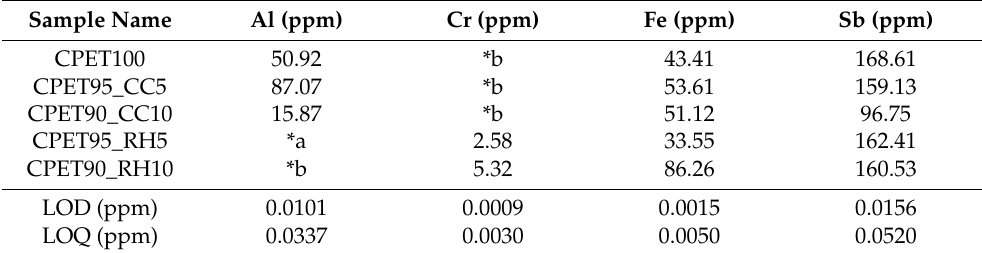
Table 3. Inorganic element composition of selected compounds (Al, Cr, Fe, Sb) in CPET and blends containing coffee chaff or rice hull as